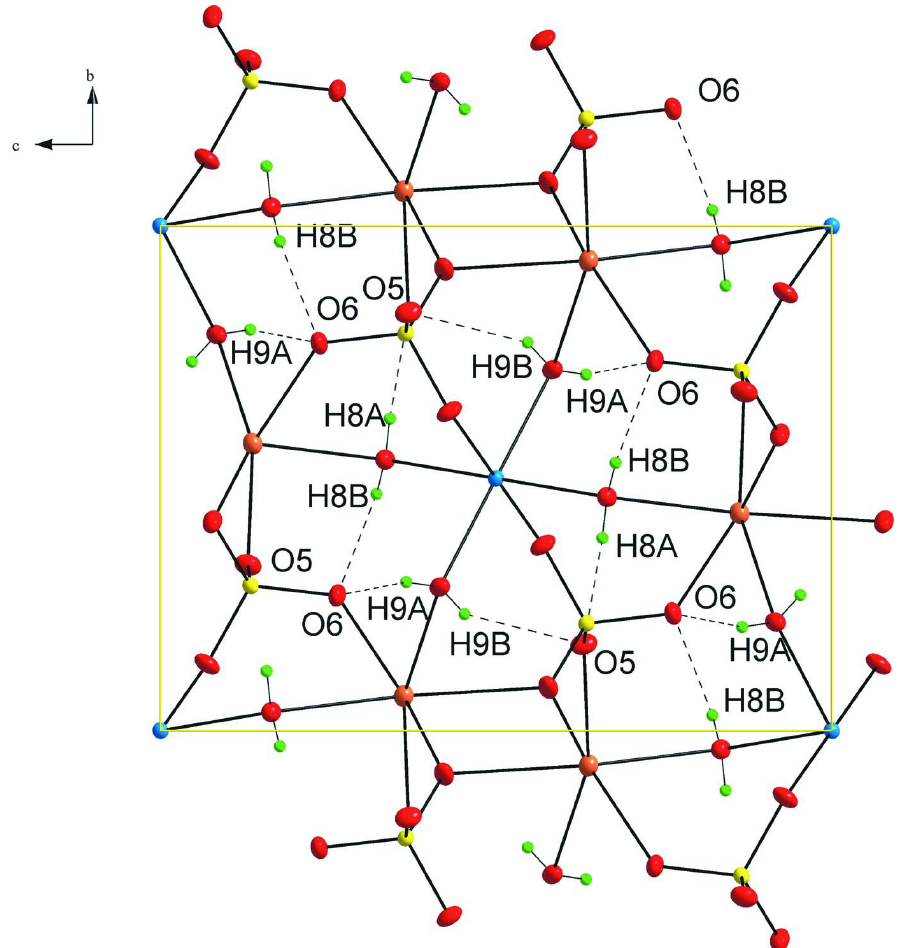
Figure 2 Packing diagram viewed along the a axis. Hydrogen-bond interactions are indicated by dashed